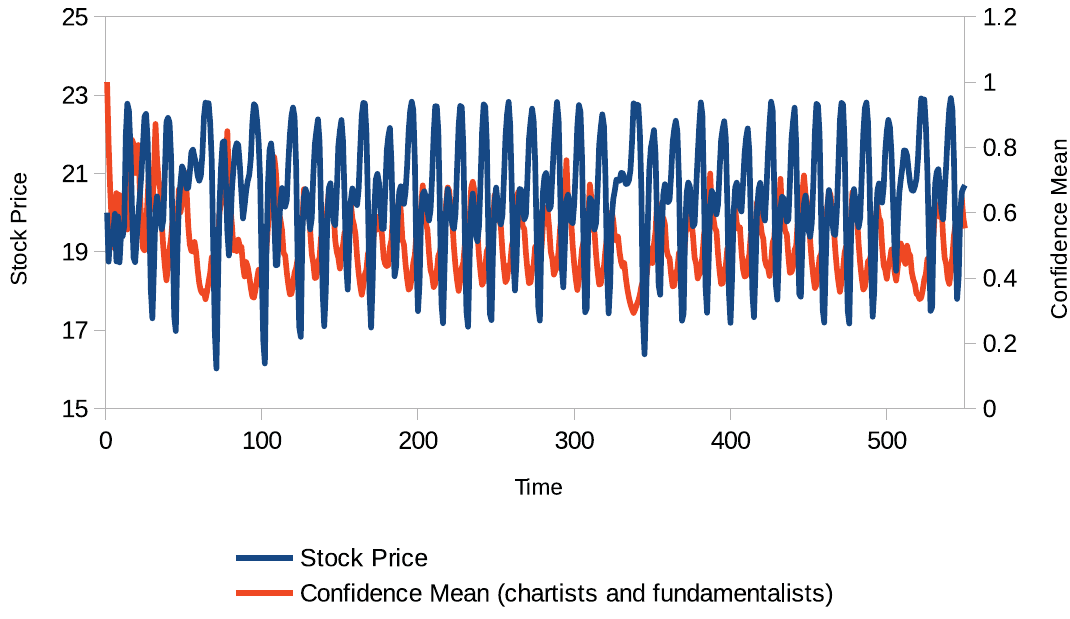
Fig 6. Level of confidence (different types of agents with confidence). Source: Own creation.